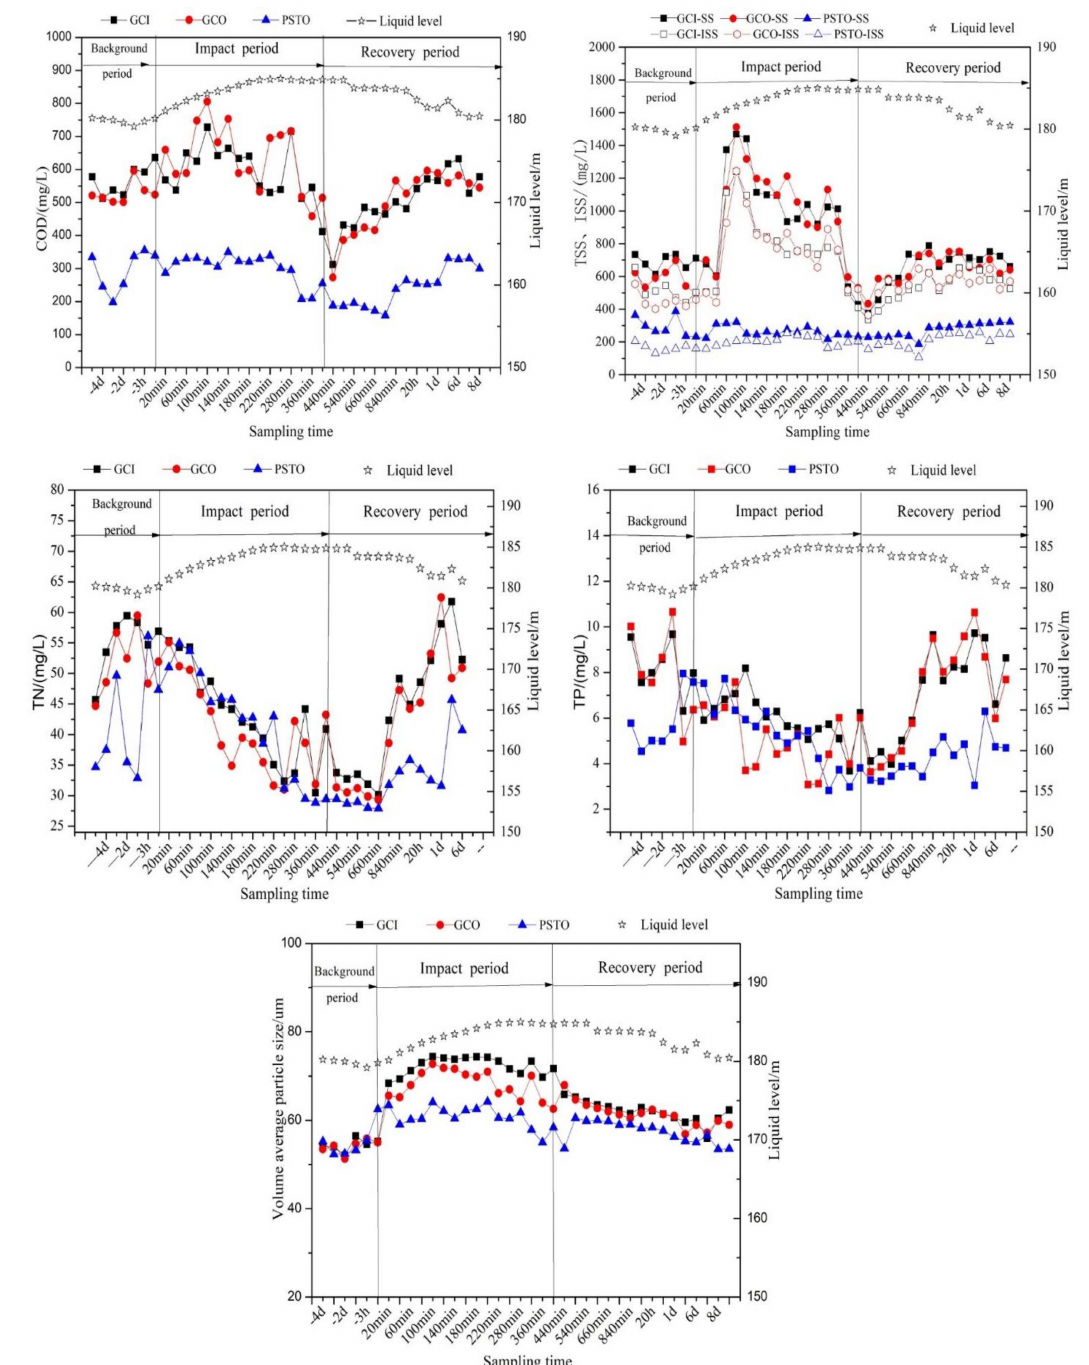
Figure 4. The variation of pollutant concentration in different periods. ISS, inorganic suspended solids; AAO, anaerobic-anoxic-oxic. Grit Chamber Influent Grit Chamber Influent—GCI; Grit Chamber Effluent—GCO; Primary Settling Tank Effluent—PSTO. Meanwhile, PSTO is also the AAO process